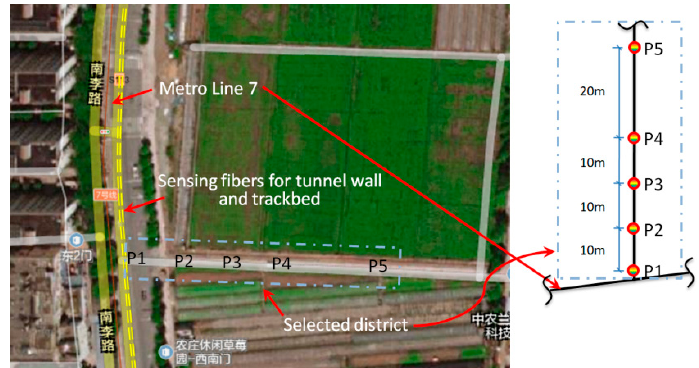
Figure 4. Sites and path of the simulated ground intrusion.